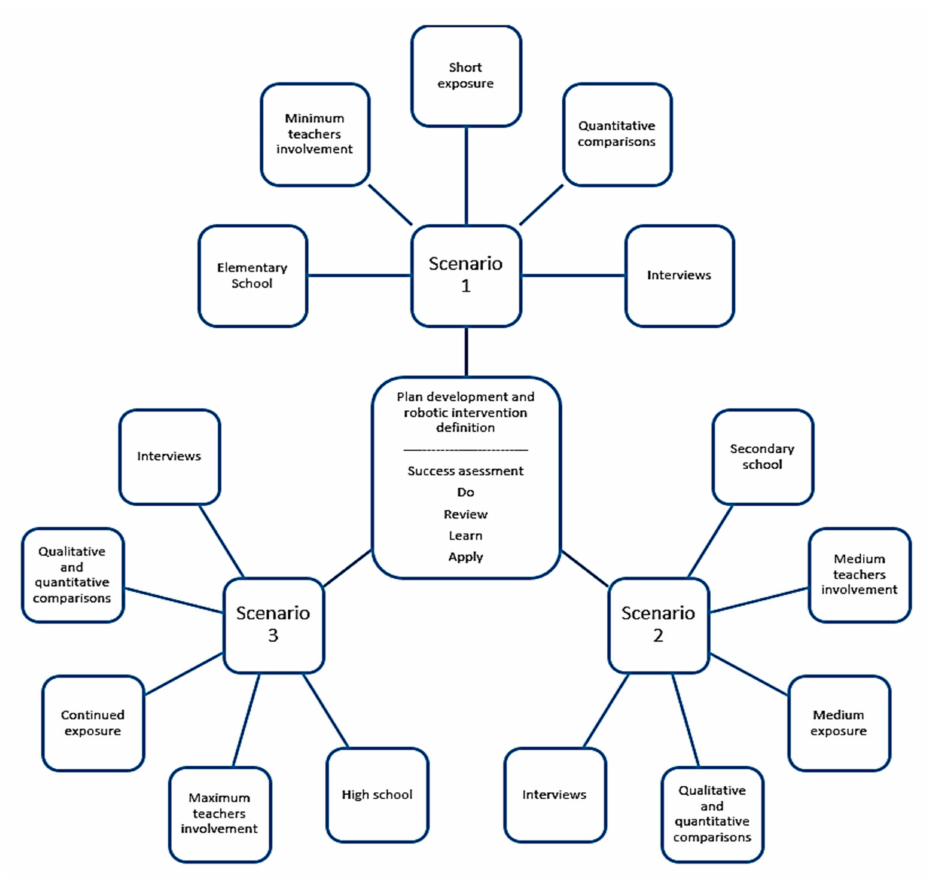
Figure 3. The robotics & active learning exploratory methodological